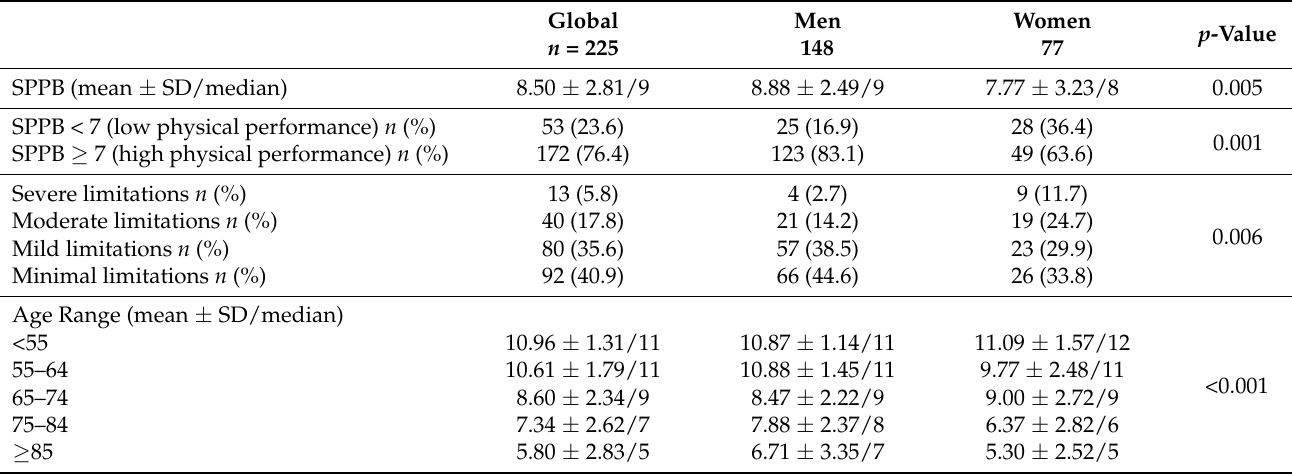
Table 2. Short physical performance battery test.